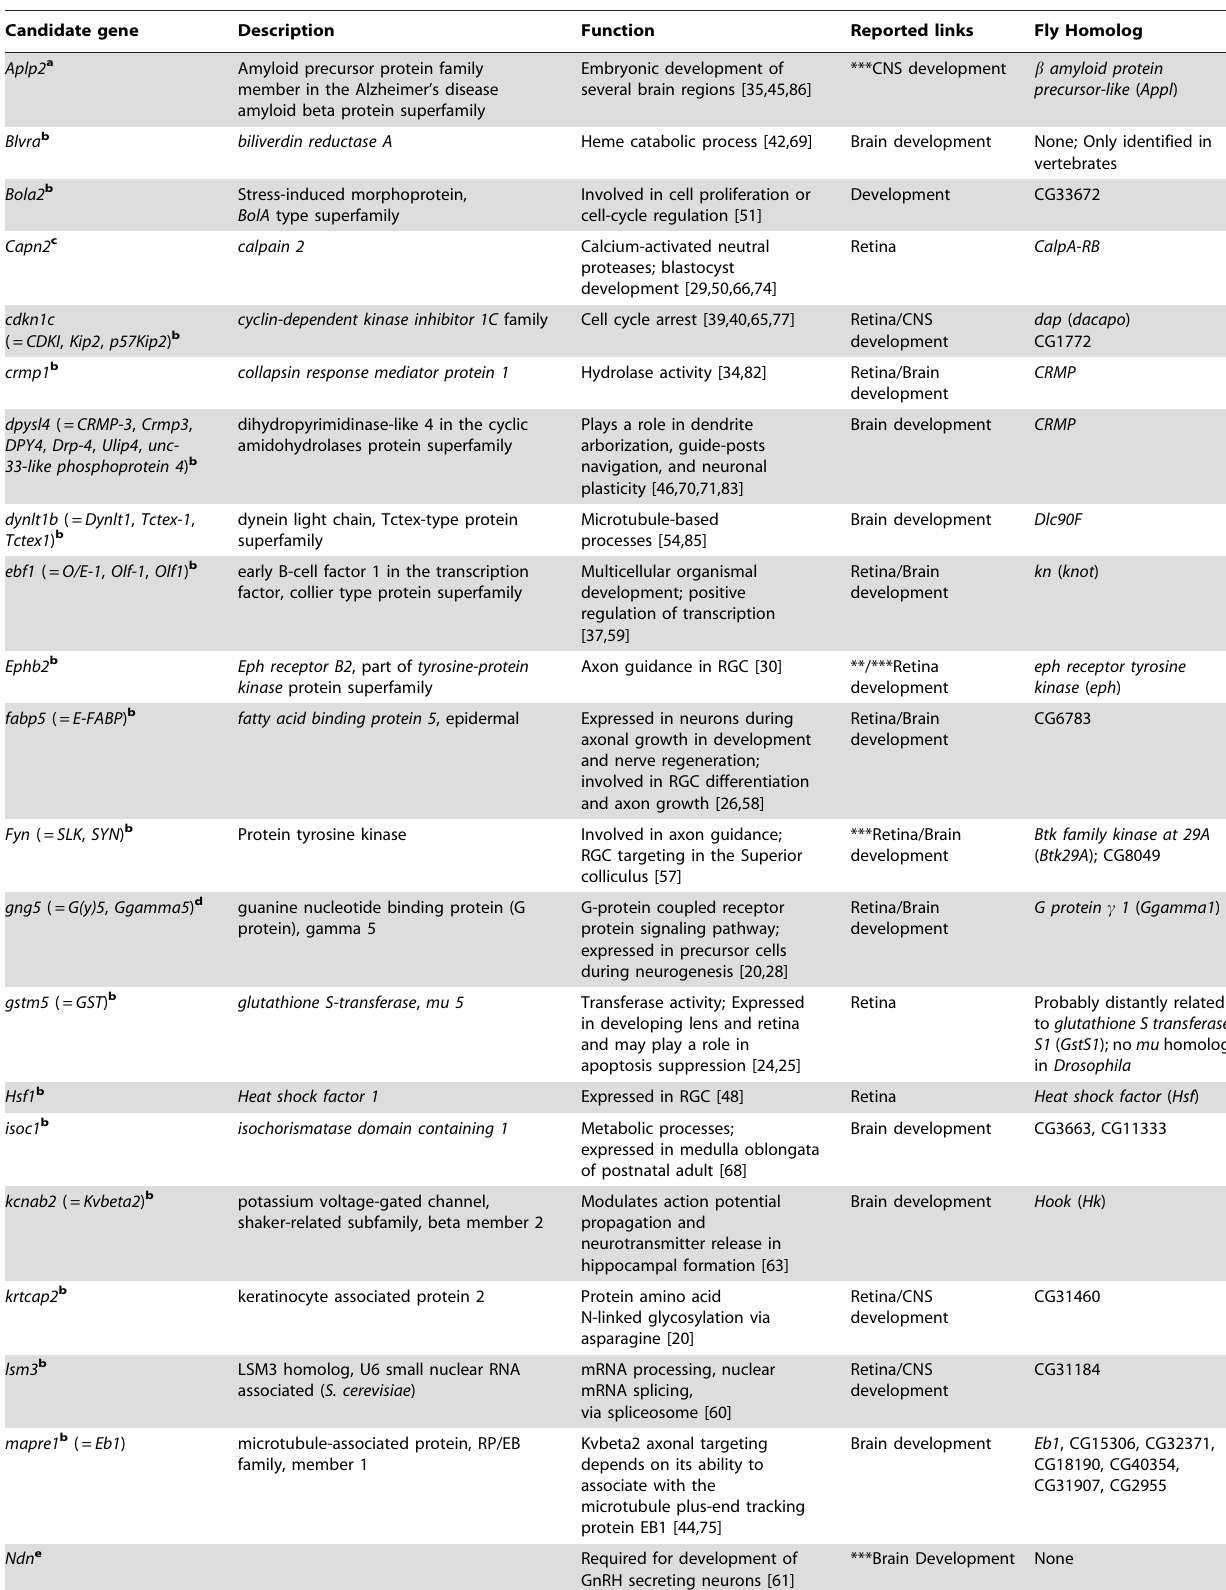
Table 3. List of 46 candidate genes found in three or more seed gene lists.